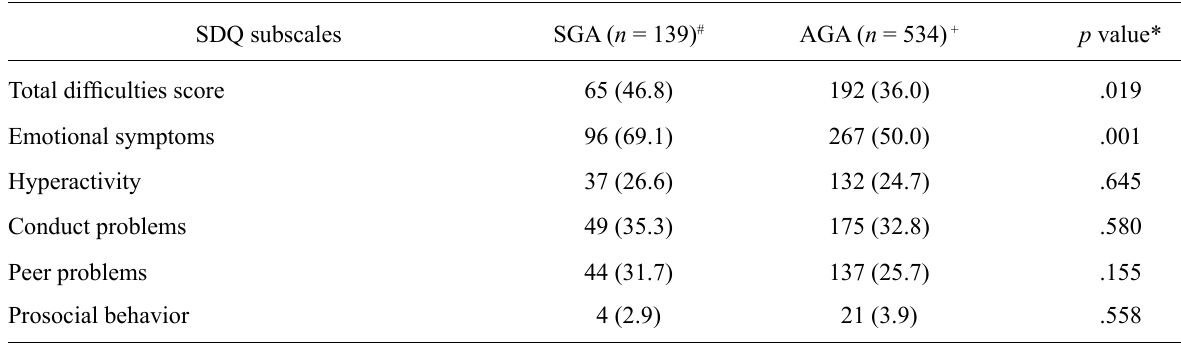
Number and (percentage) of Children Rated Abnormal by Parents in SDQ Subscales for SGA and AGA Children